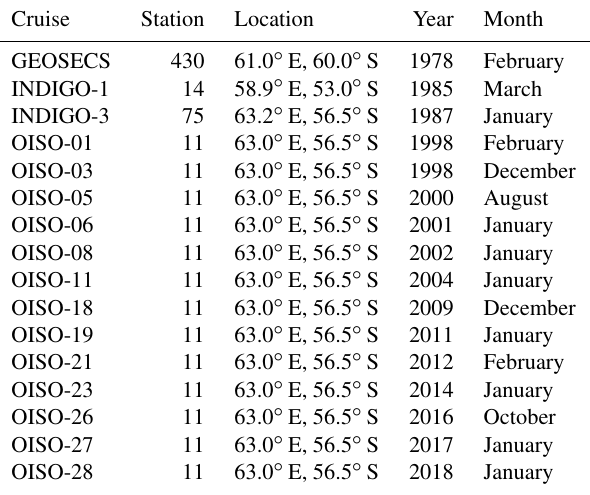
Table 1. List of the cruises used in this study.